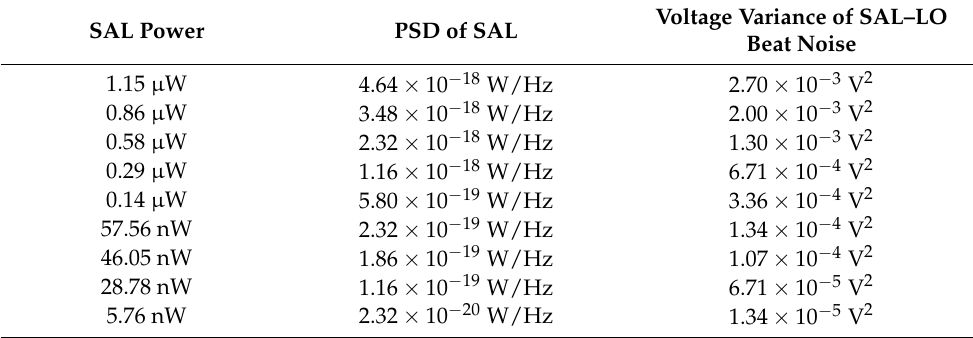
Voltage Variance of